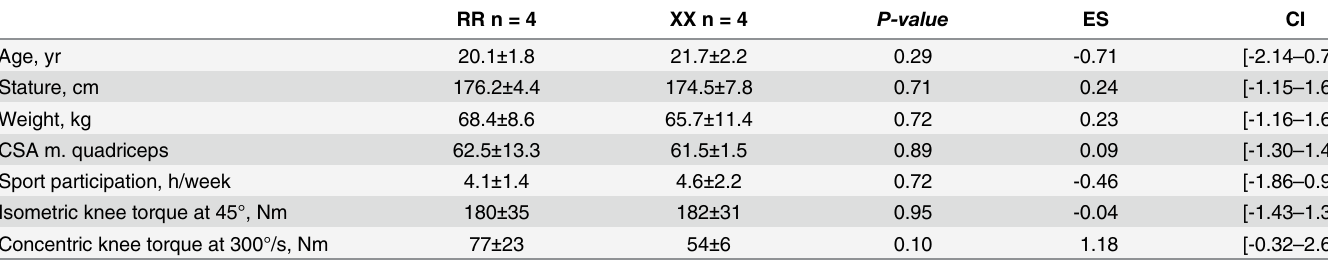
Table 1. Characteristics of the ACTN3 577RR and 577XX genotype